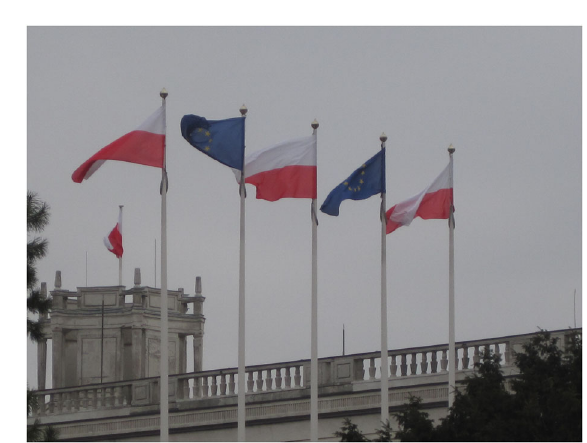
p -values are for two-sample Mann – Whitney U -tests, two-tailed. a For these variables, the codes are 1 = none; 2 = weak; 3 = moderate; and 4 = strong. b For these variables, the codes are 1 = none; 2 = few; 3 = some; and 4 = many.